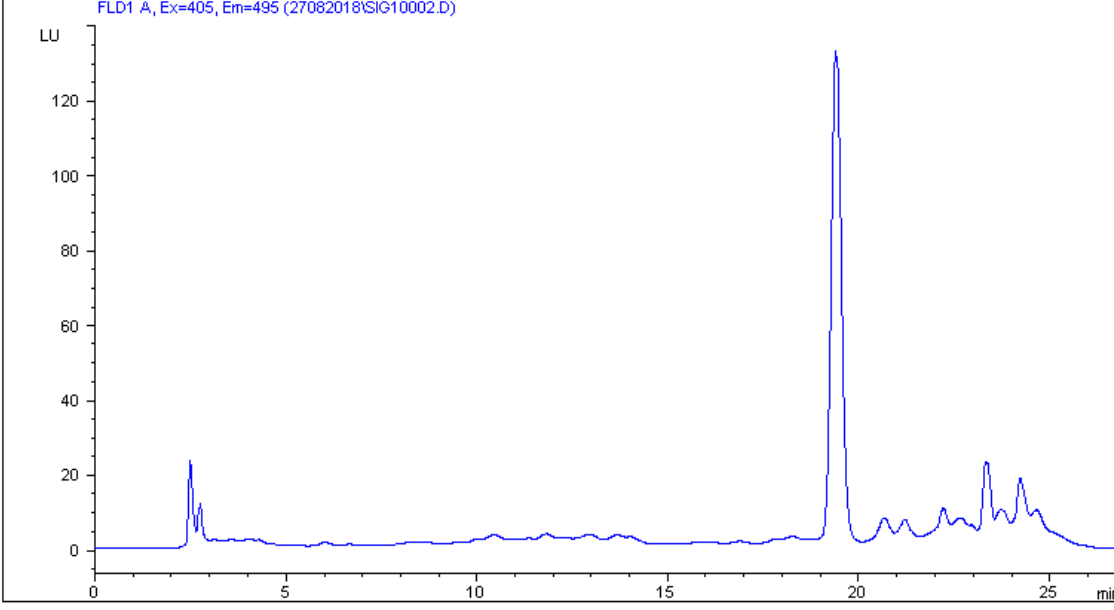
Figure 1. Blank sample of solid manure (pig feces).